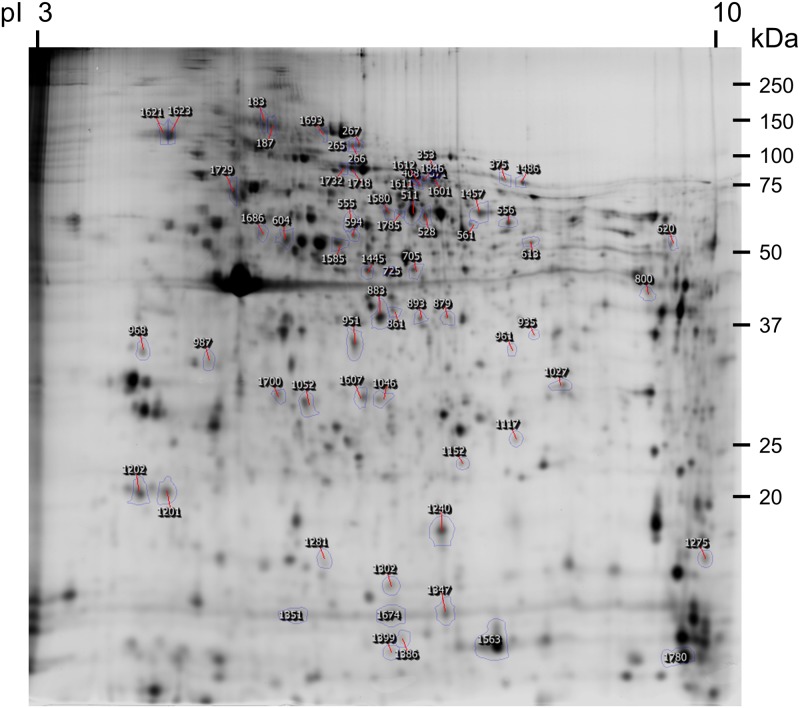
Master gel from porcine PBMC.The position of the differentially abundant spots that were identified is shown.